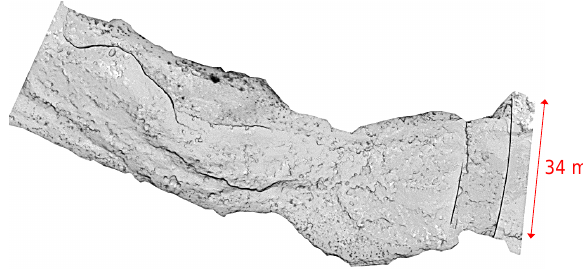
Figure 3. X-ray orthophoto of the Vegliato reach (2.5D orthophoto generated from the HERON Lite point cloud projected on the horizontal